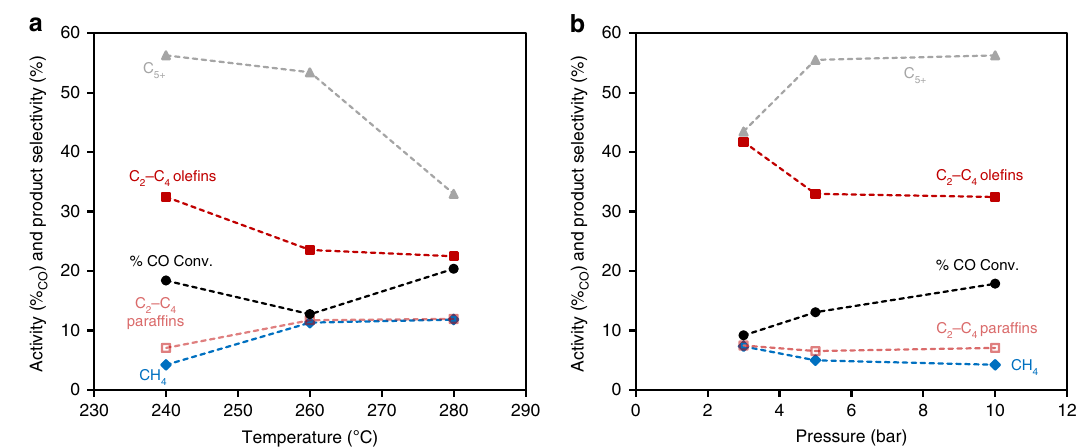
Fig. 1 Catalytic performance of Co 1 Mn 3 – Na 2 S at different reaction temperatures or pressures. a Activity and selectivity at 240 – 280 °C, 10 bar, and H 2 /CO = 2, and b activity and selectivity at 240 °C, 3 – 10 bar, and H = 2. Activity is shown here as % CO conversion and product selectivity is shown in 2 /CO terms of methane, CH 4 (blue solid diamonds), C 2 – C 4 ole fi ns (red solid squares), C 2 – C 4 paraf fi ns (light red open squares), and C 5 + (grey solid triangles) which include all other products except CO 2 and C 1 – C